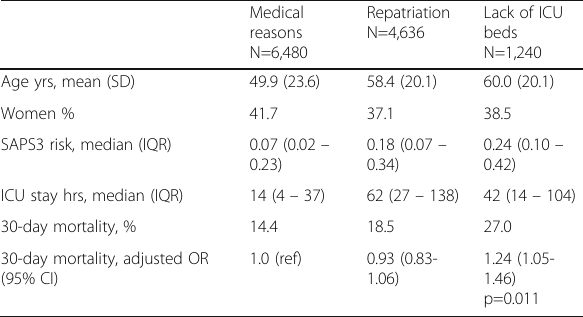
Table 1 (abstract 000228). See text for